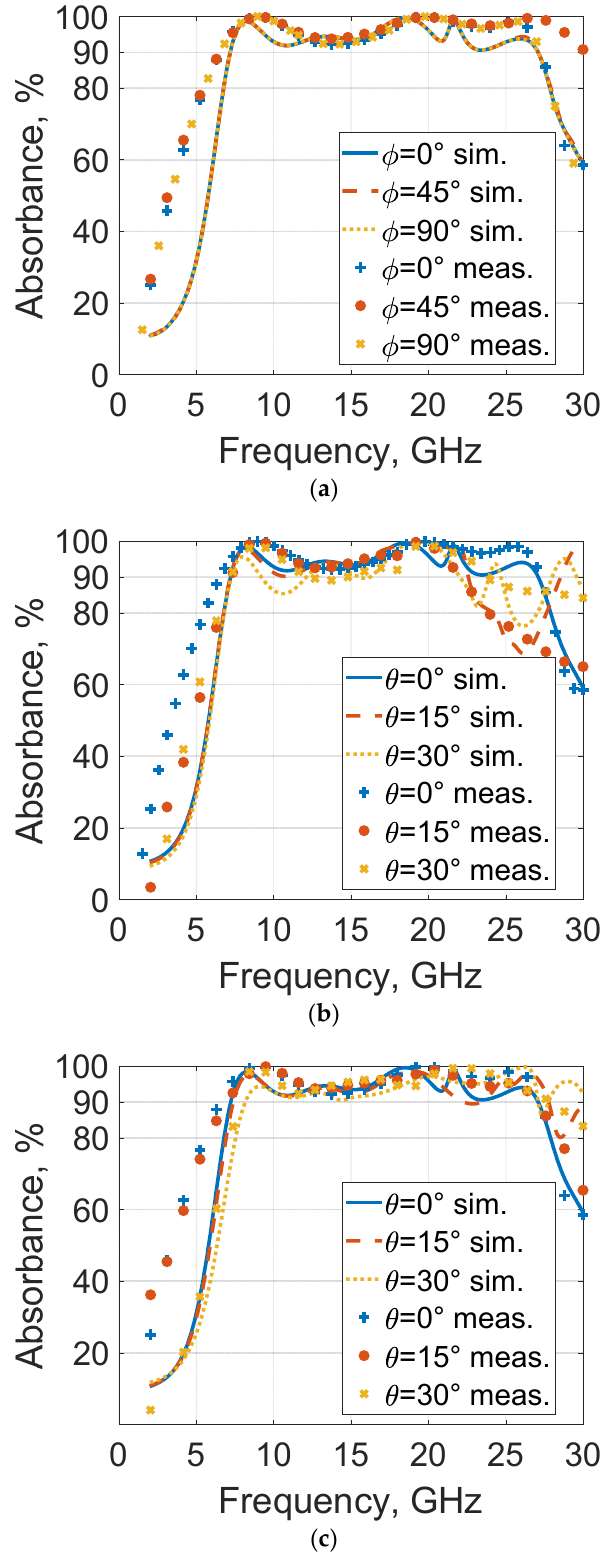
Figure 9. Measurement setup. ( a ) For various polarizations, ( b ) for various incidence angles (TE mode), and ( c ) for various incidence angles (TM modes).